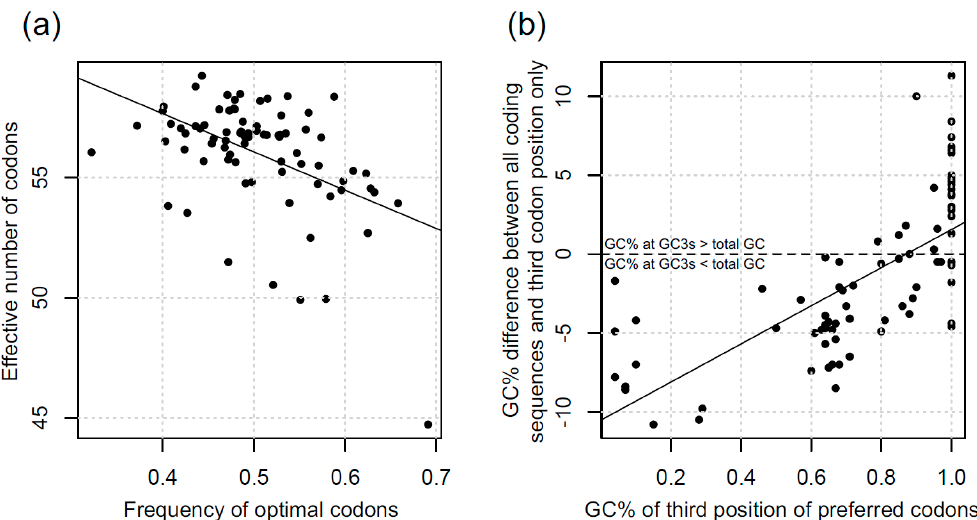
Figure 1. ( a ) Correlation between effective number of codons and frequency of optimal codons considering all genes in each species. Pearson’s correlation: rho = − 0.475, P value = 6 E ‐ 6 ; and ( b ) all genes in each species. Pearson’s correlation: rho = − 0.475, P value = 6 E-6 ; and ( b ) Correlation between Correlation between the GC% of the optimal codons’ third position and the difference of GC% the GC% of the optimal codons’ third position and the di ff erence of GC% between all the coding between all the coding genome and GC3s only. Pearson’s correlation: rho = 0.695, P value = 3 E ‐ 13 . genome and GC3s only. Pearson’s correlation: rho = 0.695, P value = 3 E-13